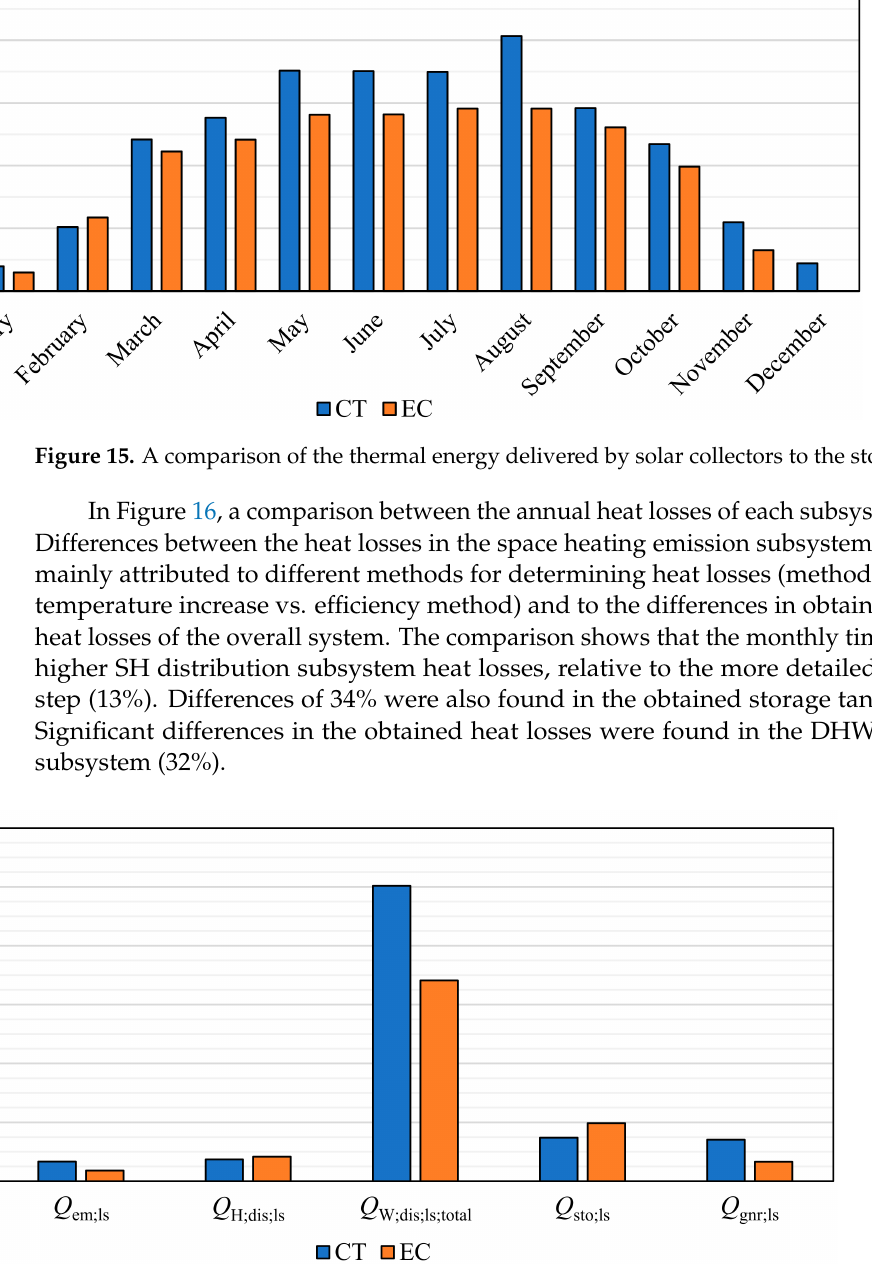
Figure 16. Comparison of heat losses of each